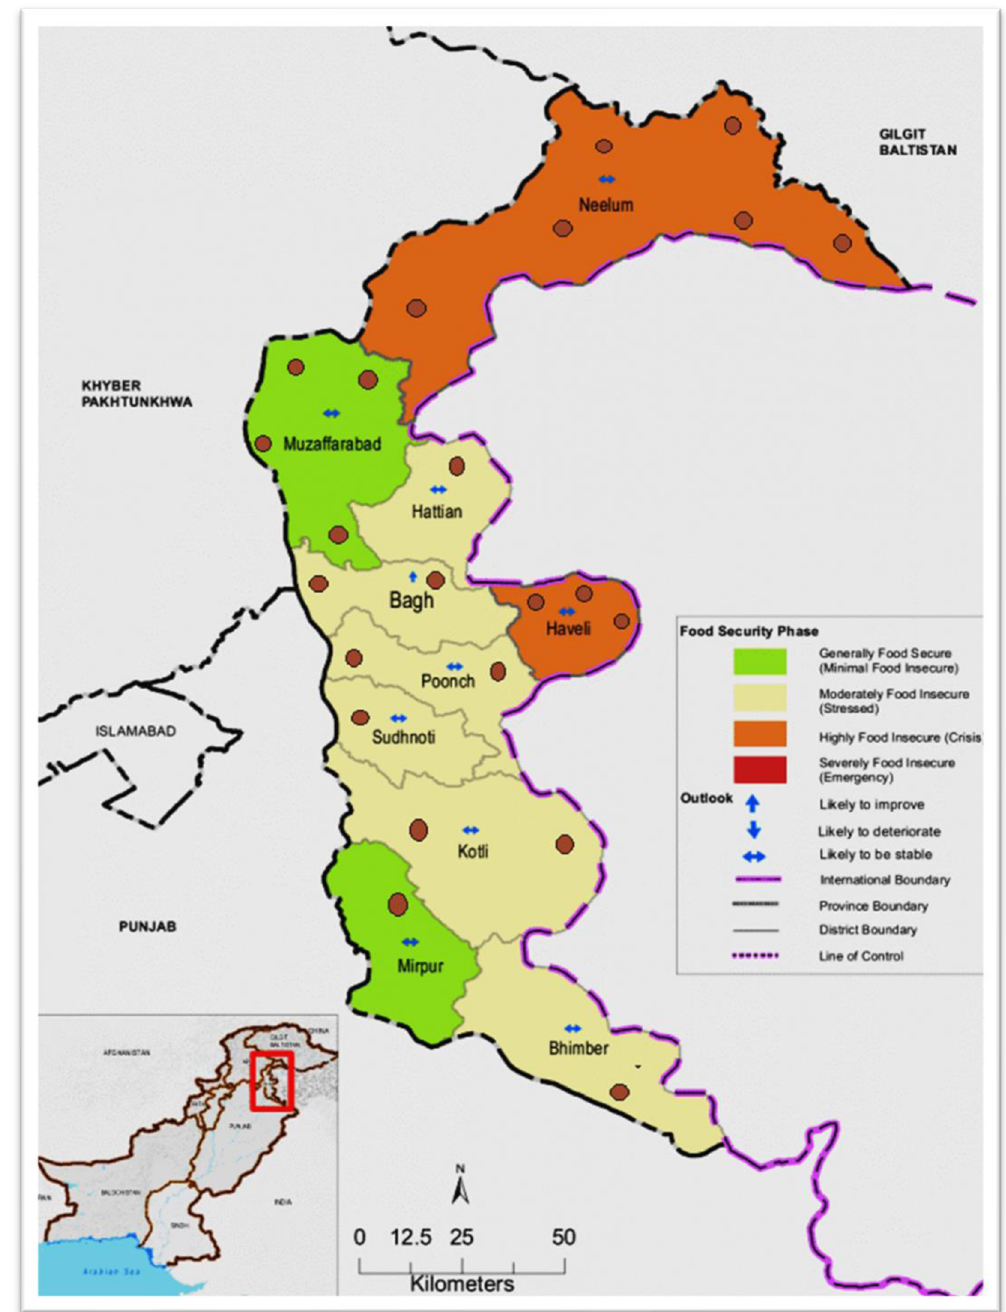
Fig 1. Map of the study area showing study sites in all district of Azad Jammu and Kashmir. (Source: https://www.ajk.gov. pk/ajkmap). and Sheldon [41]. The poisonous plants found in the research region were collected and iden- tified using the Flora of Pakistan [42], with names confirmed by literature (www.efloras.org/ index.aspx) and the Kew grass database (https://www.kew.org/data/grasses-db/index.htm).